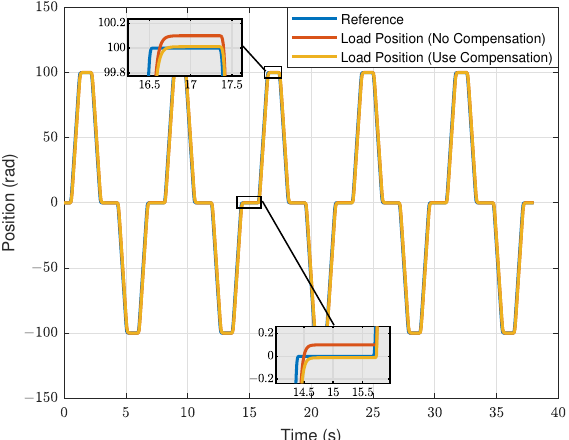
Figure 9. Position control comparison with and without backlash compensation.